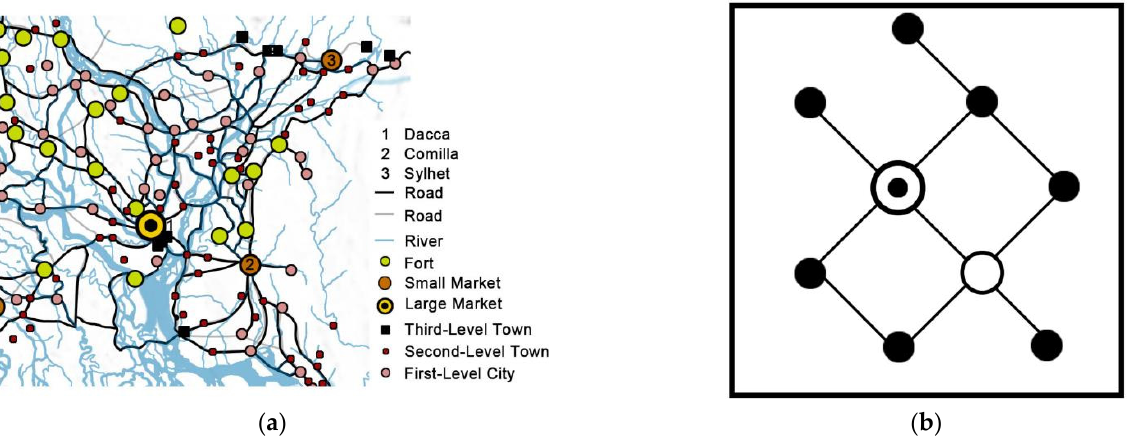
Figure 15. ( a ) Spatial pattern of the city network in the eastern GBM Delta. Source: the authors; Base Map: Google satellite map; Reference: [65]; ( b ) Decentralized pattern dominated by sociocultural factors. Source: the authors.